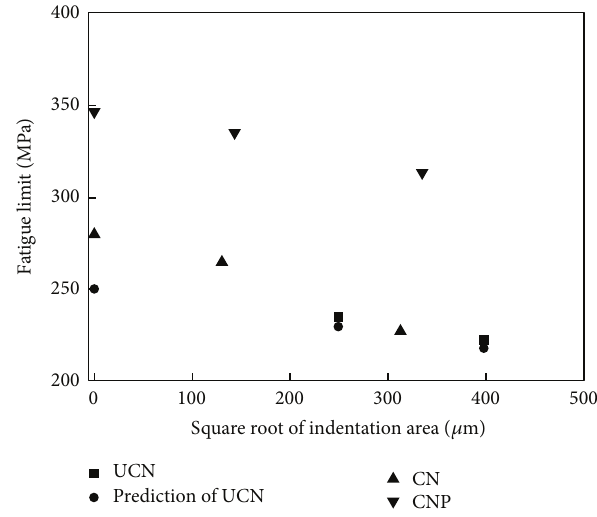
Figure 6: The relationship between the fatigue limit and the indentation